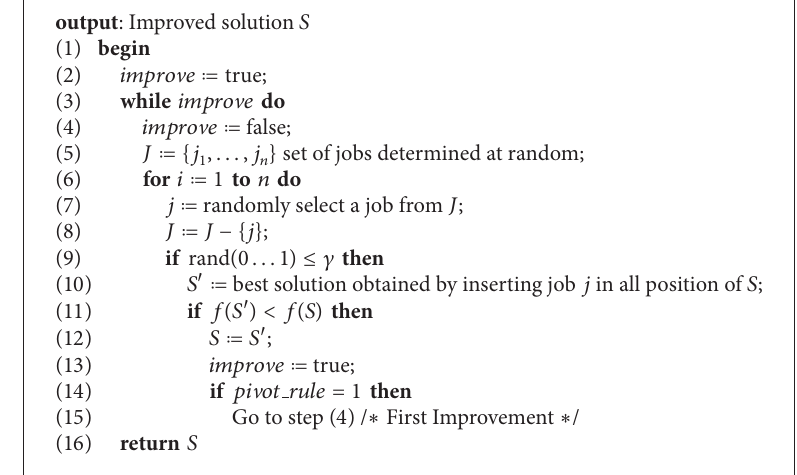
Algorithm 4: LOCAL SEARCH( 𝑆 , 𝛾 , 𝑝𝑖 V 𝑜𝑡 𝑟𝑢𝑙𝑒 ).